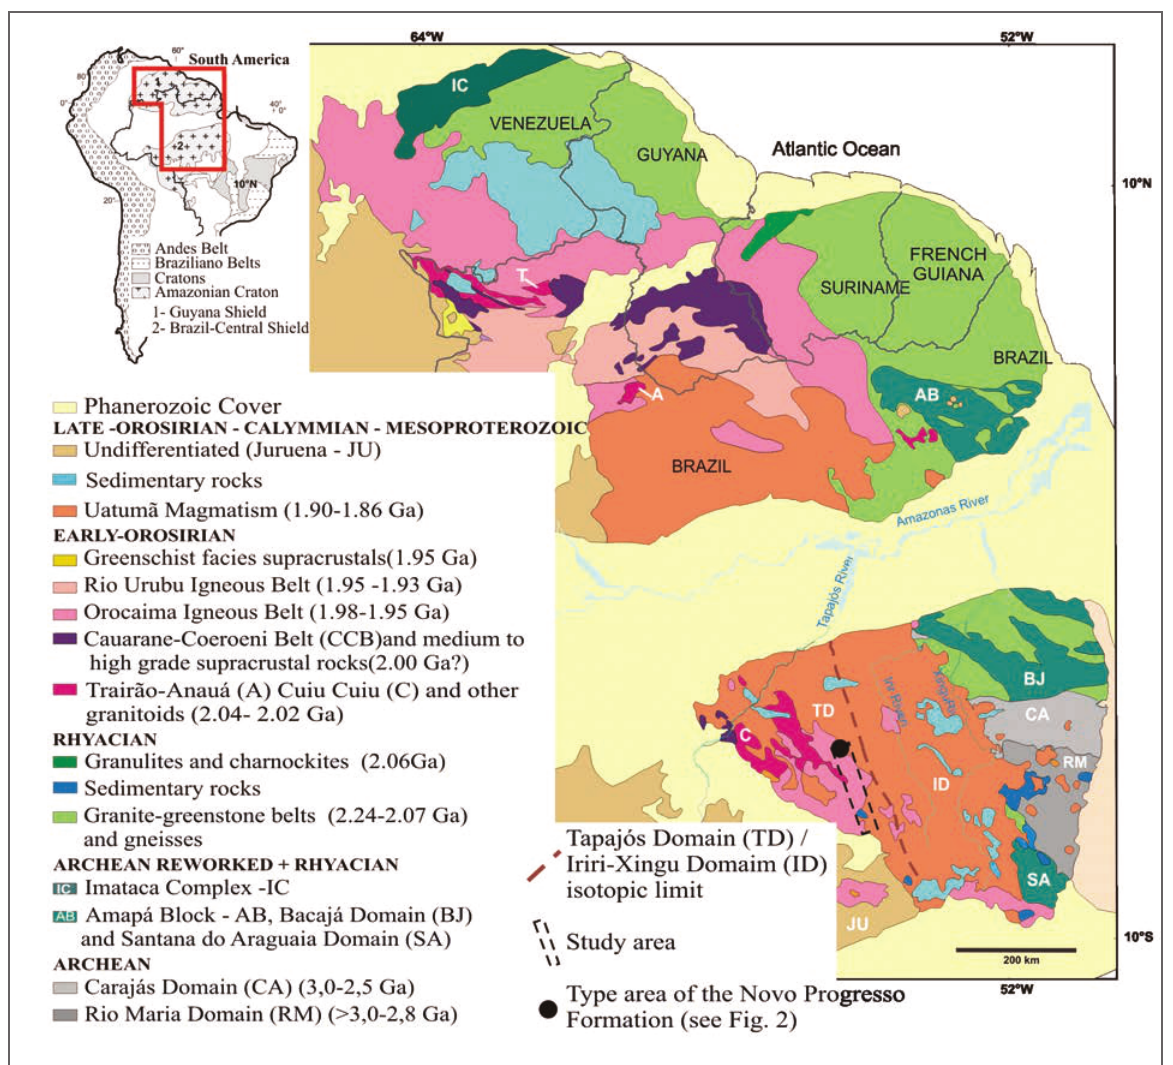
Figure 1 - Simplified geological map of the Amazonian Craton (modified from Fraga et al. 2017), with indications of the tectonic domains discussed in the text, and location of the study